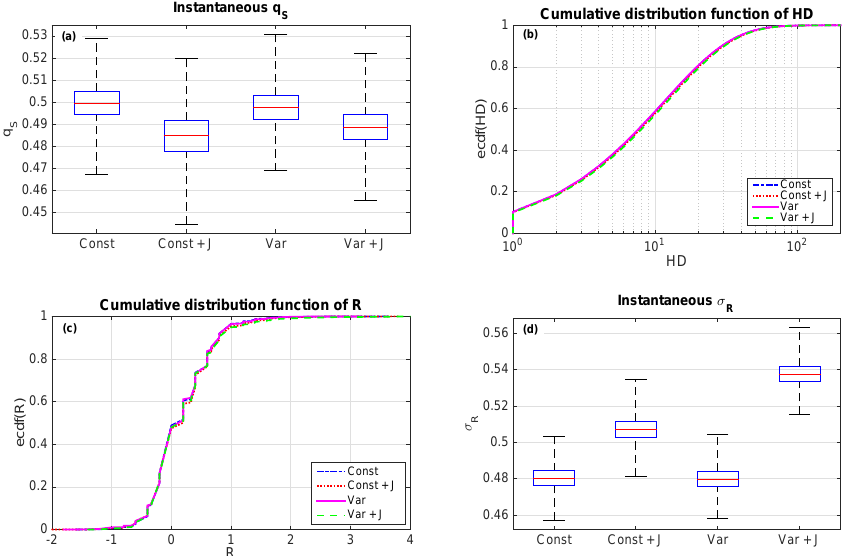
Figure 8. Comparison between constant input rate (“Const” without jamming and “Const + J ” with jamming) and variable input rate (“Var” without jamming and “Var + J ” with jamming). (a) Box plots of the instantaneous values of specific sediment flux q S . (b) Empirical cumulative distribution function of particle hop distances HD. (c) Empirical cumulative distribution function of relative exposure R computed on the entire control volume at the end of the simulation. (d) Box plots of the instantaneous values of the spatial standard deviation of relative exposure σ R .